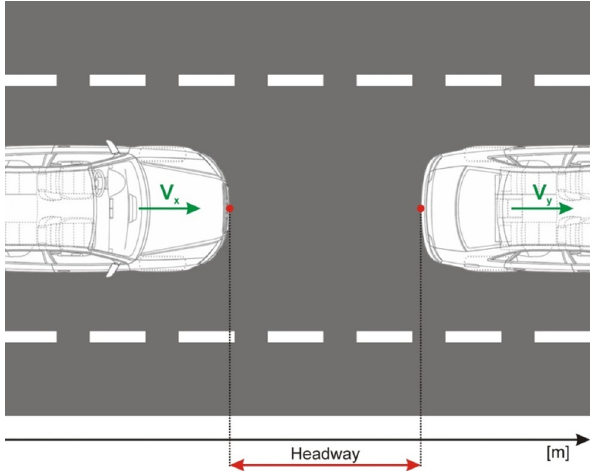
Figure 3: De fi nition of headway [ 12 ]